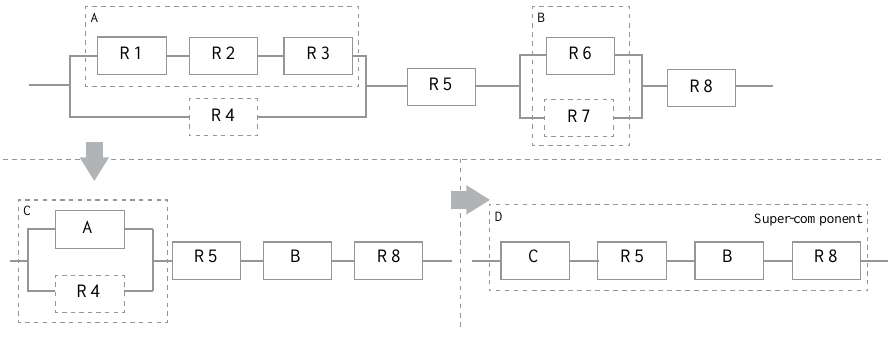
Fig. 7. System reliability